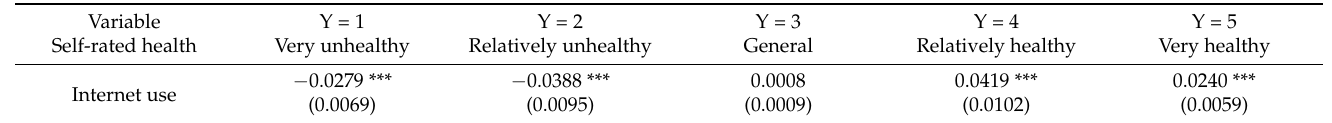
Table 3. Marginal effects of Internet use on self-rated health of the elderly.